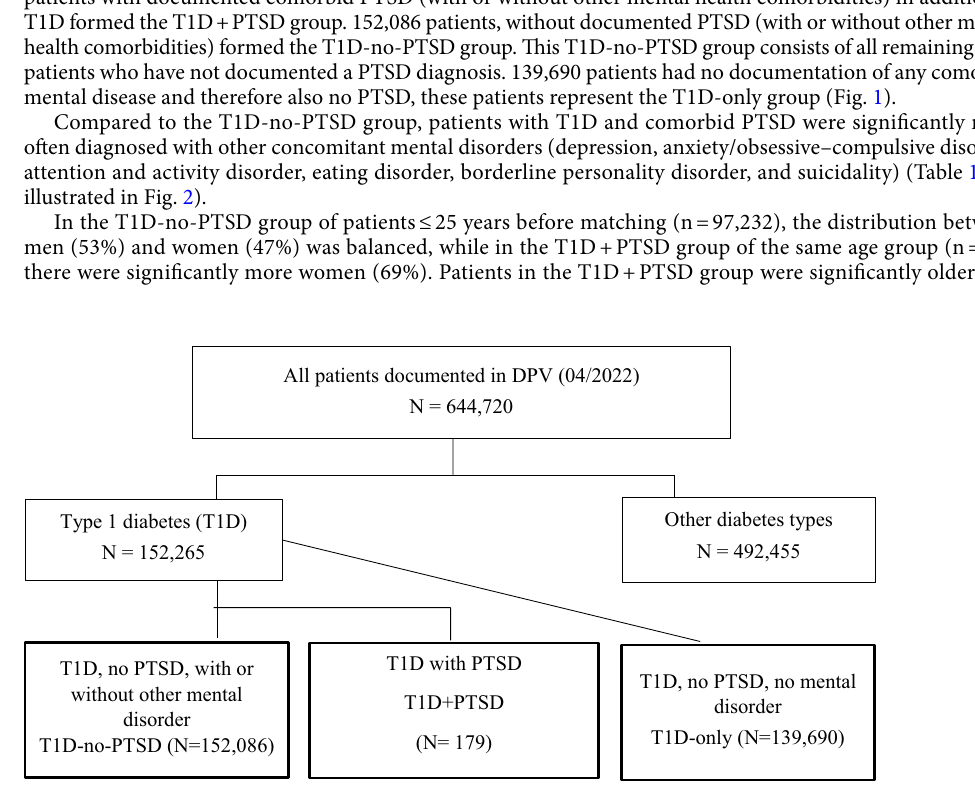
Figure 1. Selection of study population and group information . Flow chart. T1D type 1 diabetes, DPV diabetes prospective follow-up, PTSD posttraumatic stress disorder, T1D-no-PTSD patients with T1D, with